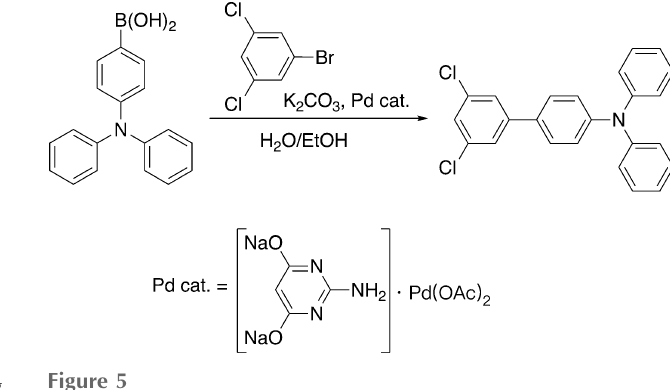
Figure 2 Crystal packing of the title compound viewed along [010] illustrating head-to-tail dimer formation.